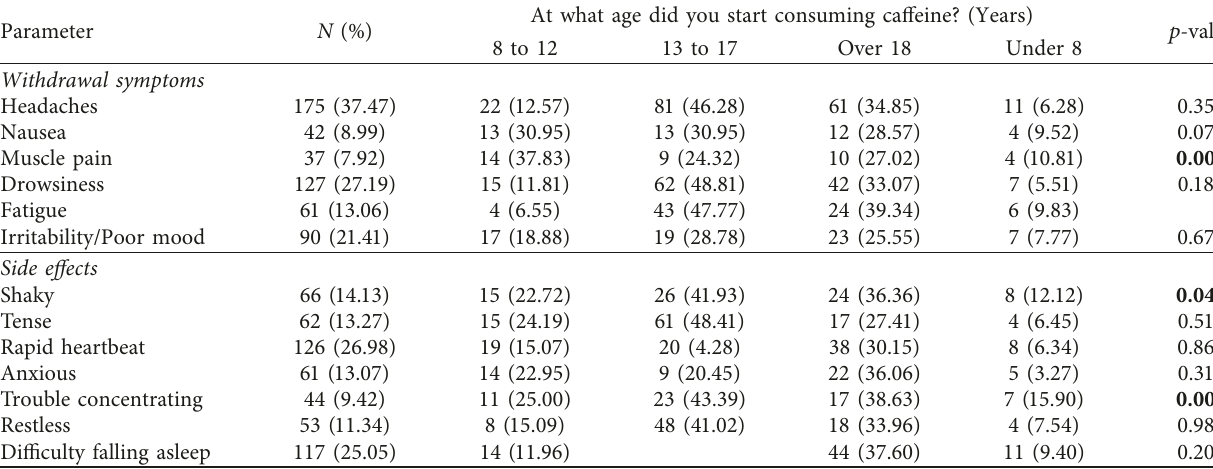
Table 4: Caffeine side effects and withdrawal